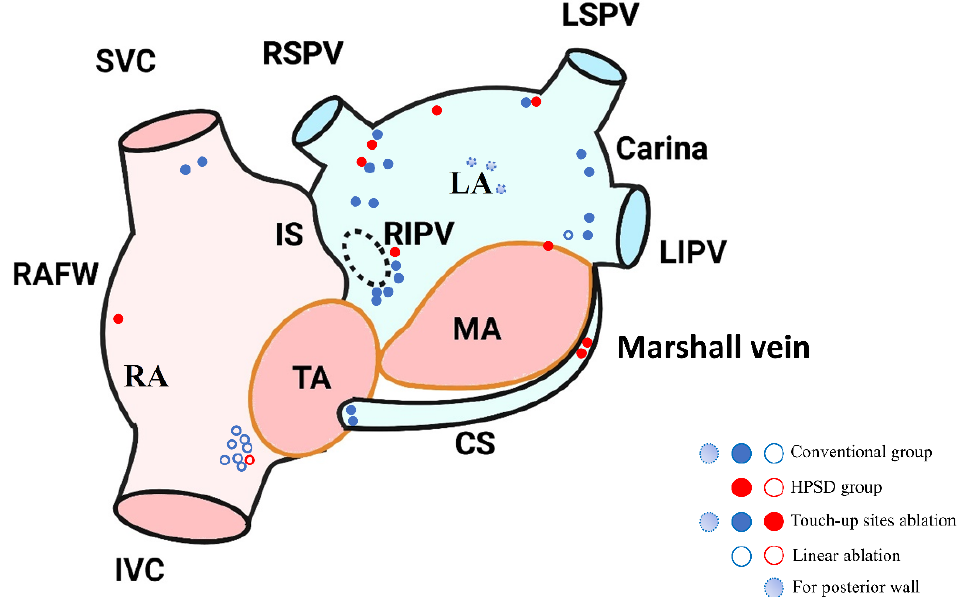
Figure 3. Anteroposterior schematic diagram of trigger sites during repeat procedure for recurrent